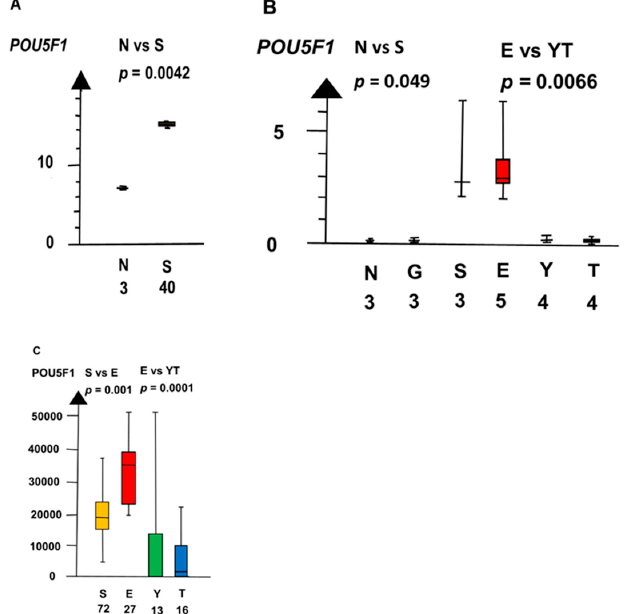
Figure 6. RNA expression of POU5F1 in three datasets ( A – C ) show that seminoma (S) and embryonal carcinoma (E) had a high RNA expression and that germ cell neoplasia in situ (G), yolk sac tumor (Y), and teratoma (T) had a low RNA expression. SE and EC had a seven times higher RNA expression of KLF4 than all other histologic types combined (median 4.9 vs. 0.71, p = 0.0073, Kruskal–Wallis test), as indicated in Figure